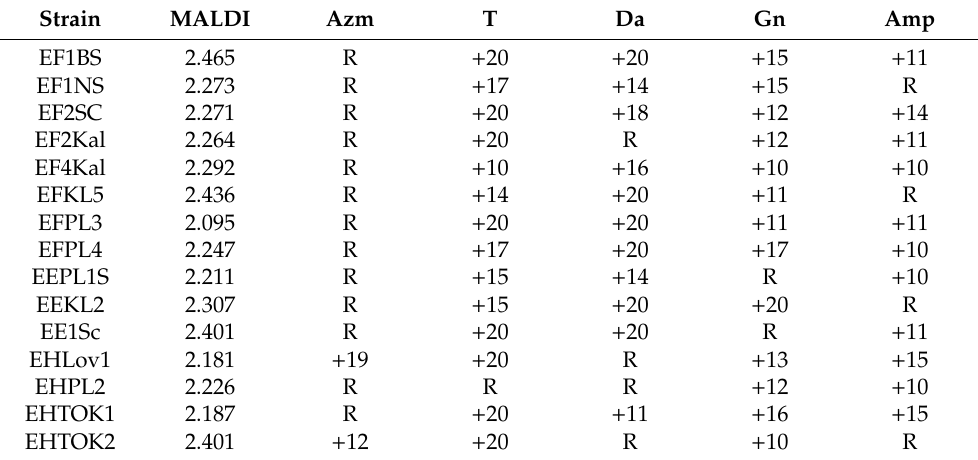
Table 1. Enterococci MALDI-TOF identification scores and antibiotic profiles. Strain MALDI